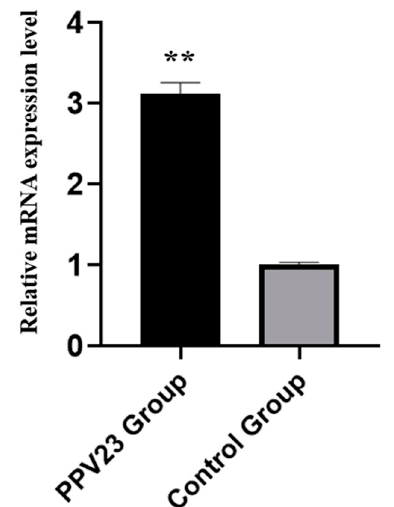
Figure 7. The validation of RNA − seq using qRT − PCR (n = 3). ( A ) qRT-PCR validation of six mRNAs. ( B ) qRT − PCR validation of six lncRNAs.